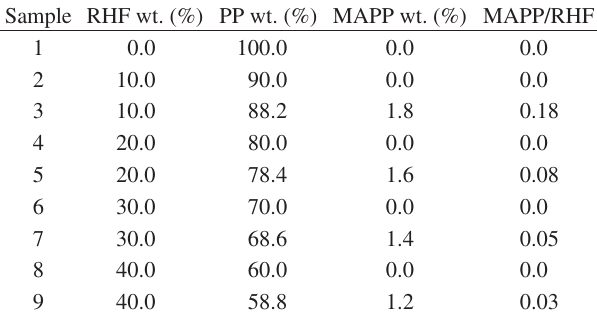
Table 1. Formulation of the PP/RHF